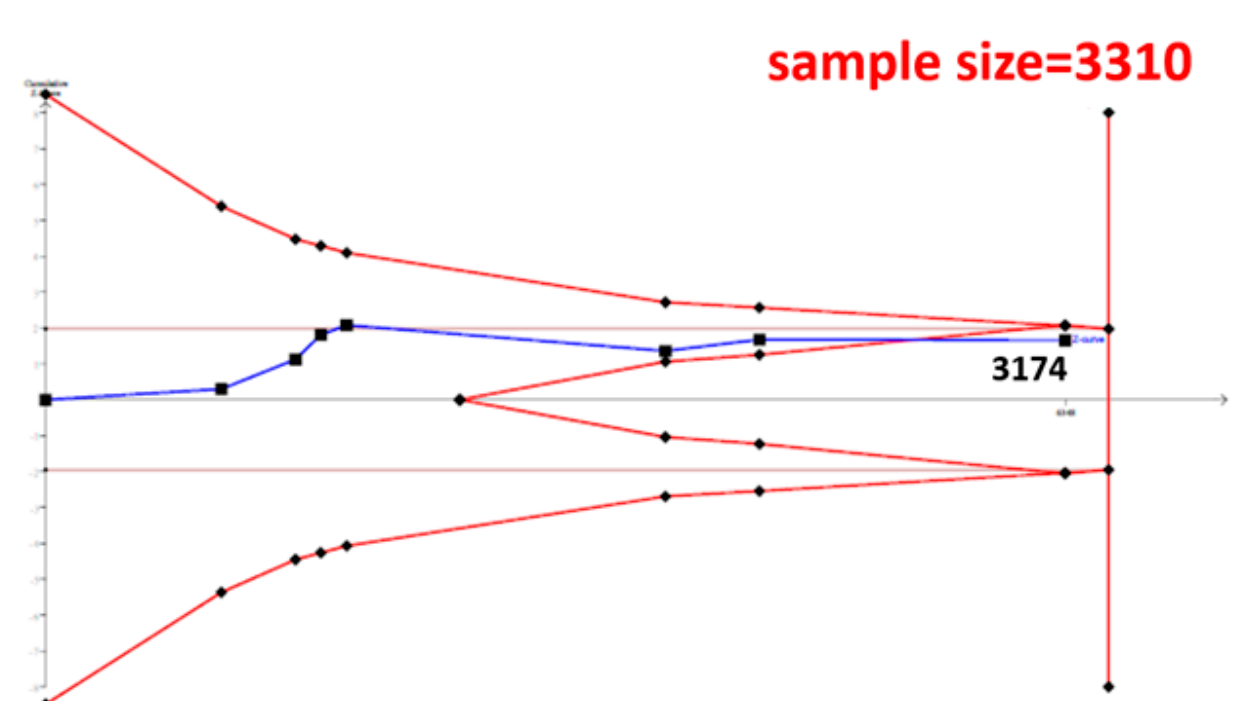
Figure 3. Trial Sequential Analysis (TSA) in Asians. We performed a TSA using an allele model assumption but replaced the allele count with the sample size (divided by 2). Detailed settings: Significance level = 0.05; Power = 0.8; ratio of controls to cases = 1; hypothetical proportion of controls with G allele = 0.19; least extreme OR to be detected = 1.5; I 2 (heterogeneity) = 80%.